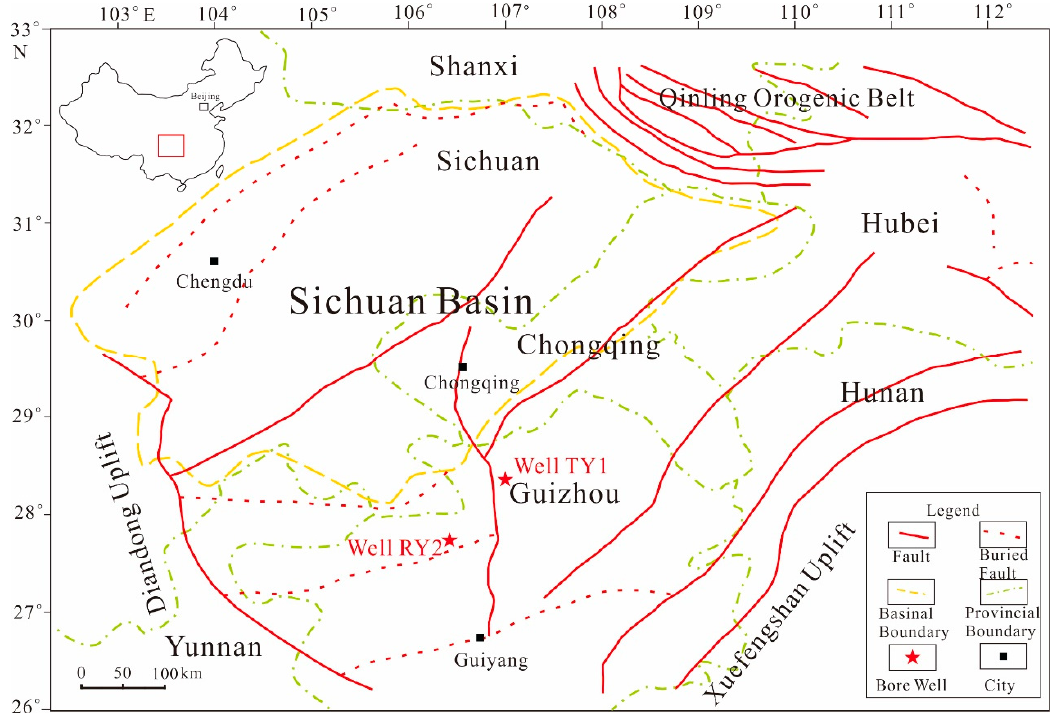
Figure 2. Location map of sampling wells in southern China (modified from [10]).